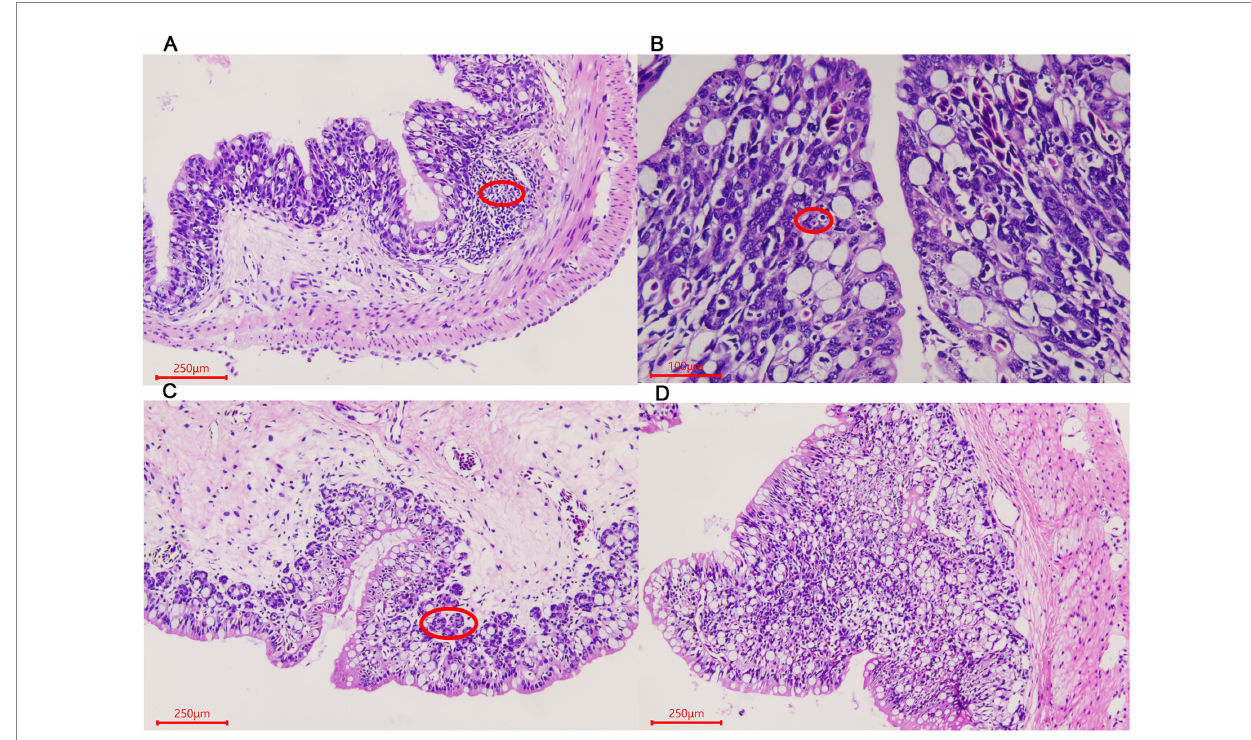
FIGURE 3 Morphological changes of the rectum in A. davidianus. (A) Rectum in ADG. (B) Rectum in ADY. (C) Rectum in ADE. (D) Adenoid structure of rectum in ADE. The sections were observed using high power fields of 500-fold magnification with several measurements at different positions in each